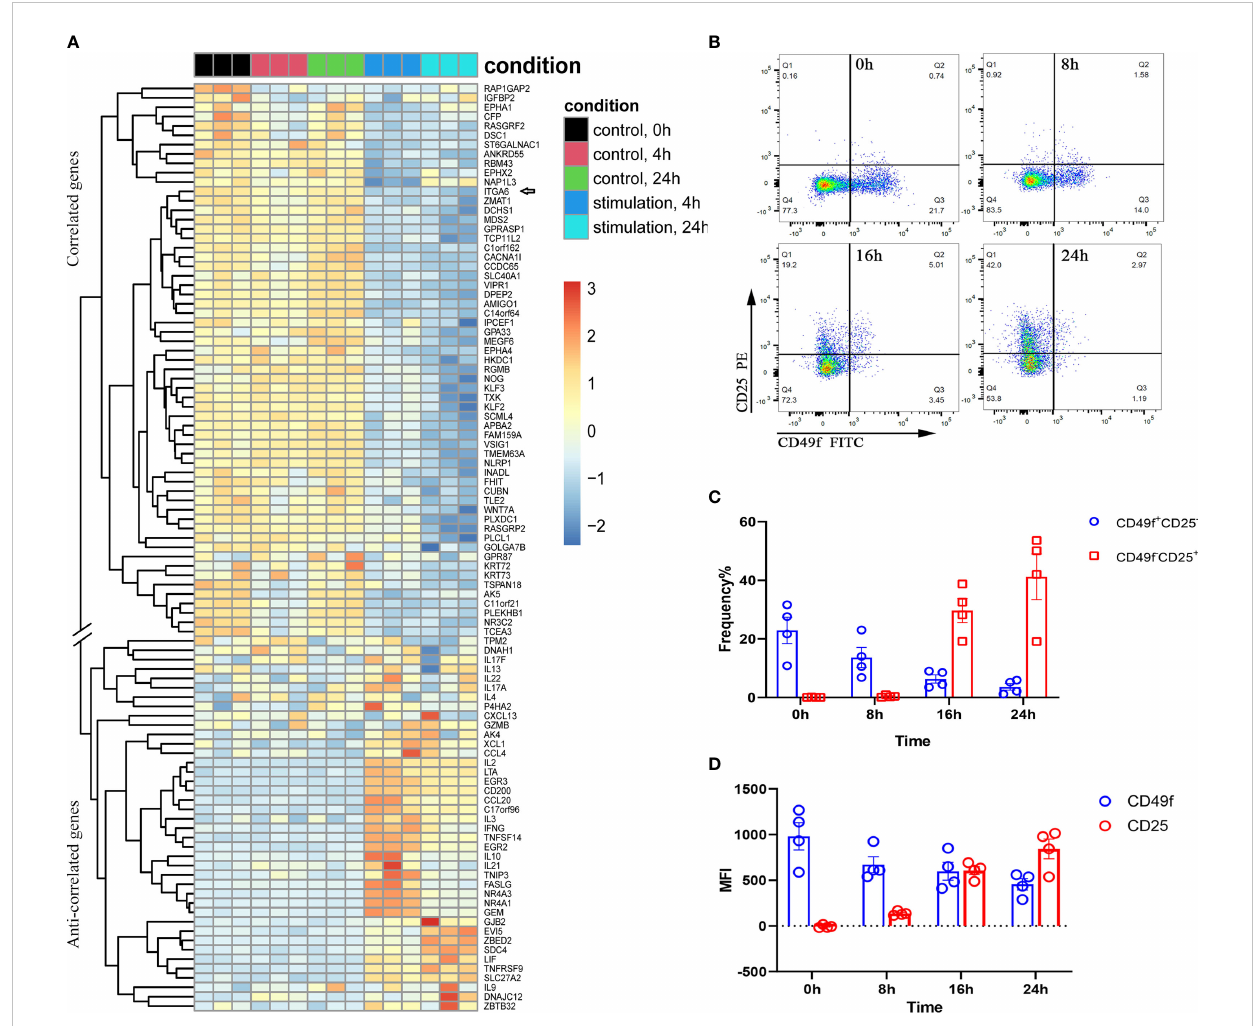
FIGURE 5 The correlated and anticorrelated genes of ITGA6 identi fi ed by virtual sorting are differentially expressed during T-cell activation. (A) Differential expression of the correlated and anticorrelated genes when naïve CD4 + T cells are activated by anti-CD3 and anti-CD28 at different time points. The dataset is derived from GSE39594. The arrow indicates the gene ‘ ITGA6 ’ . The correlated and anticorrelated genes with double slash separation are indicated on the left of the panel. (B) The scatter plot shows the decreased CD49f + and increased CD25 + T cells after activation. (C, D) represent FACS results of anticorrelated expression between CD49f (ITGA6) and CD25 (IL2RA) in either positive cell frequency (proportion) (C) or MFI (D) in CD8 + T cells. In (B – D) , CD49f (ITGA6) is downregulated, whereas the anticorrelated gene CD25 is upregulated when CD8 + T cells are activated by PMA and ionomycin at different time points. CD8 + T cells were isolated from four independent healthy